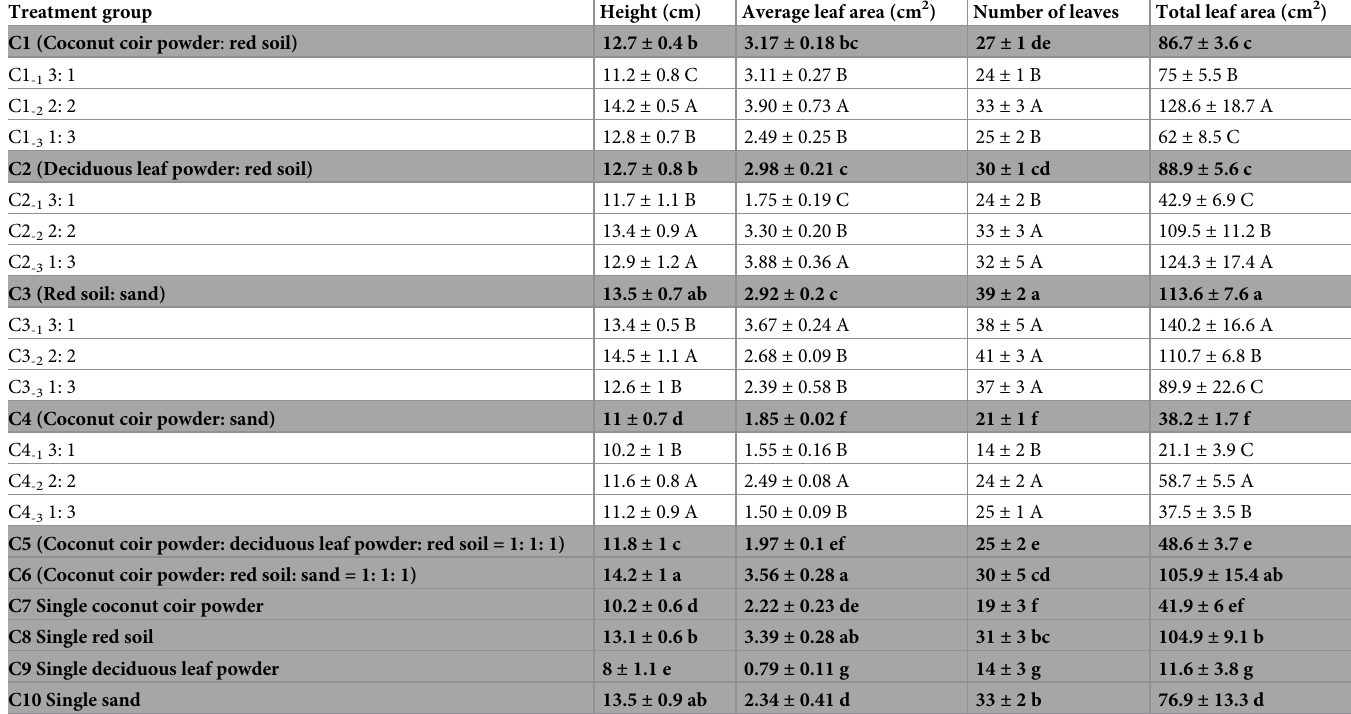
Table 1. Effect of various substrate combinations and proportions on the growth of D . odorifera seedlings. Different lowercase letters in the same column indicate the significant difference among different substrate combinations (P < 0.05). Different uppercase letters in the same column indicate the significant difference among the same substrates with different proportions (P <